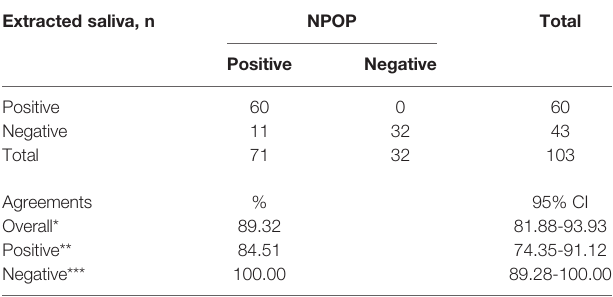
TABLE 1 | SARS-CoV-2 detection from RNA extracted from NPOP versus saliva sample types. Extracted saliva,